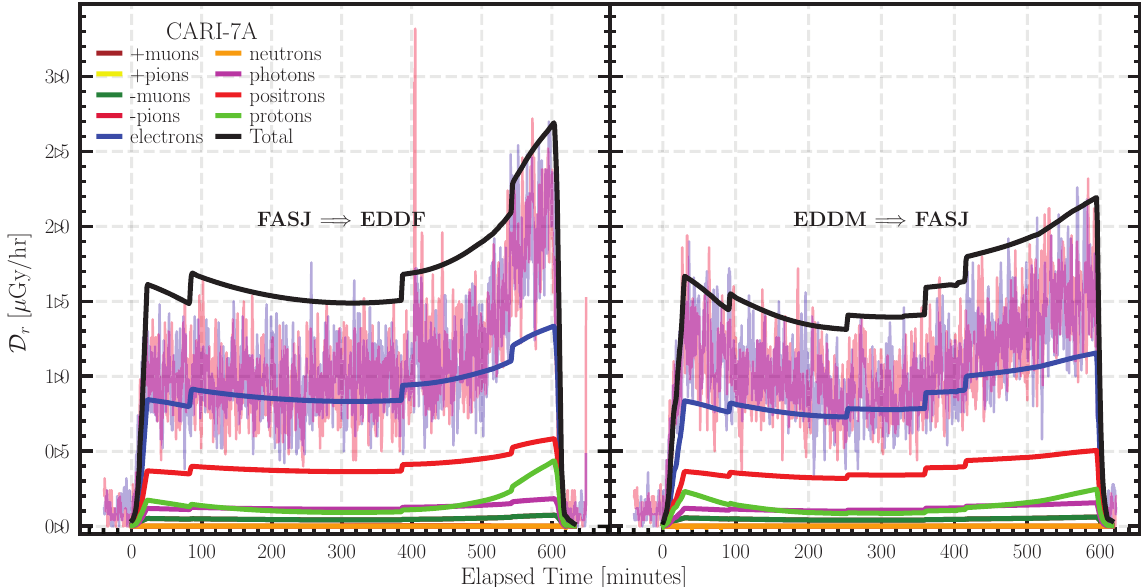
Figure B.1. Comparison of the CARI-7A model calculated absorbed doses in a 0.3 mm Si diode to the RPiRENA measured doses. The red and blue fl uctuating lines represent the SD 1 and SD 2 RPiRENA diode measurements, respectively. Supplementary data are available on the